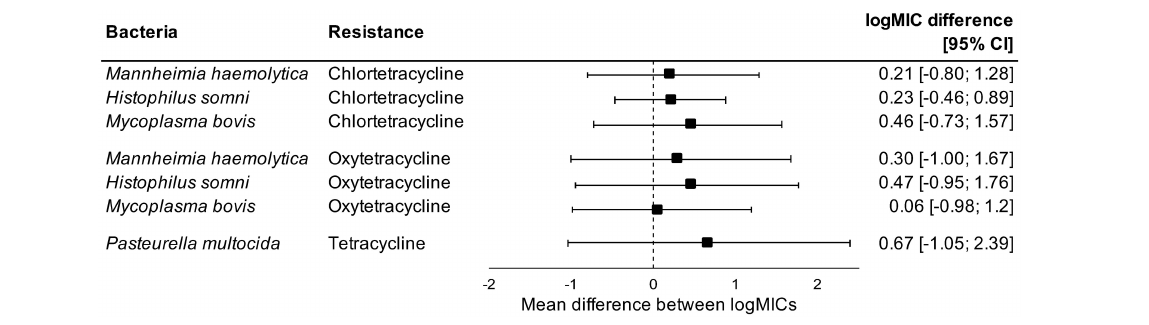
Frontiers in Veterinary Science |